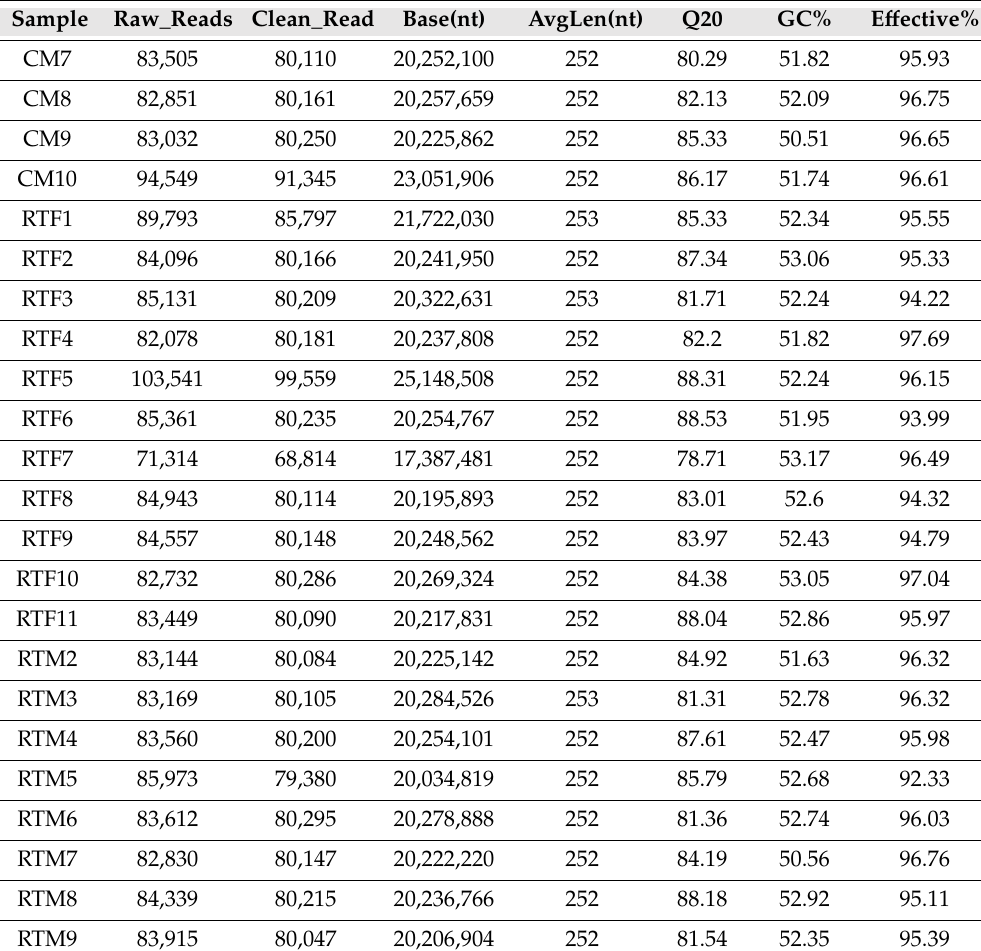
homogenized. Subsequent Alpha and Beta diversity analyses were based on homogenized data. Alpha Diversity was used to analyze the microbial community diversity of the within-community. The dilution curve, rank abundance curve, and species accumulation curve were plotted using R software. The differences between groups of Alpha Diversity indices were also analyzed using the above software. Beta Diversity was a comparative analysis of the microbial community composition of di ff erent samples. Principal Co-ordinates Analysis (PCoA) and Non-Metric Multi-Dimensional Scaling (NMDS) diagrams were drawn using R software. Di ff erences in Beta diversity indices between groups were calculated by parametric and non-parametric tests using R